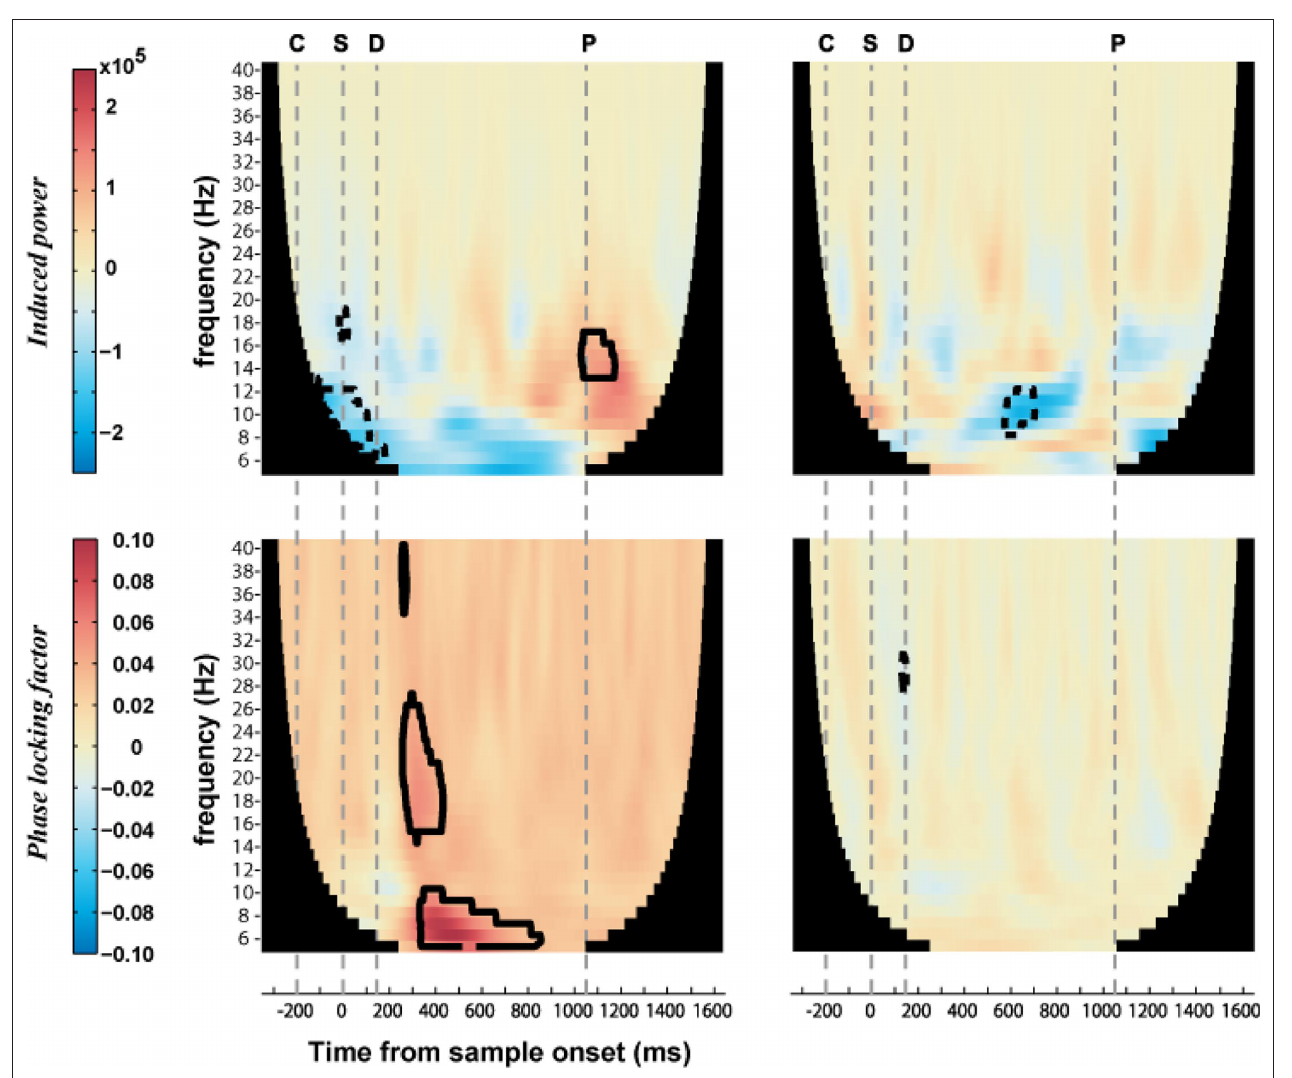
where there is a significant effect of accuracy above baseline levels (posterior probability > 0.99). The onset of the cue, sample, delay, and earliest possible probe are marked by the gray dashed lines labeled C, S, D, and P,